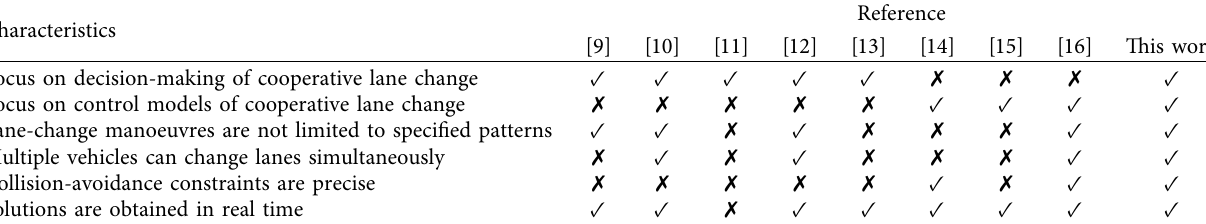
Table 1: Comparison of different